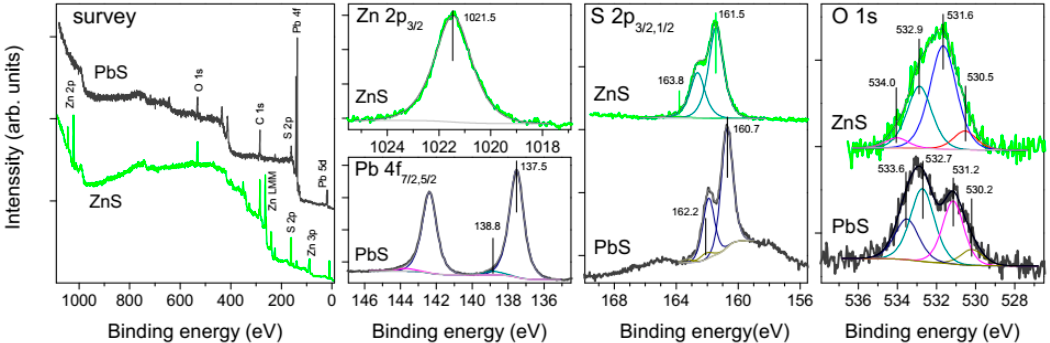
Figure 4. X-ray photoelectron spectra collected from polished and washed plates of natural PbS and ZnS used in the contact angle measurements.